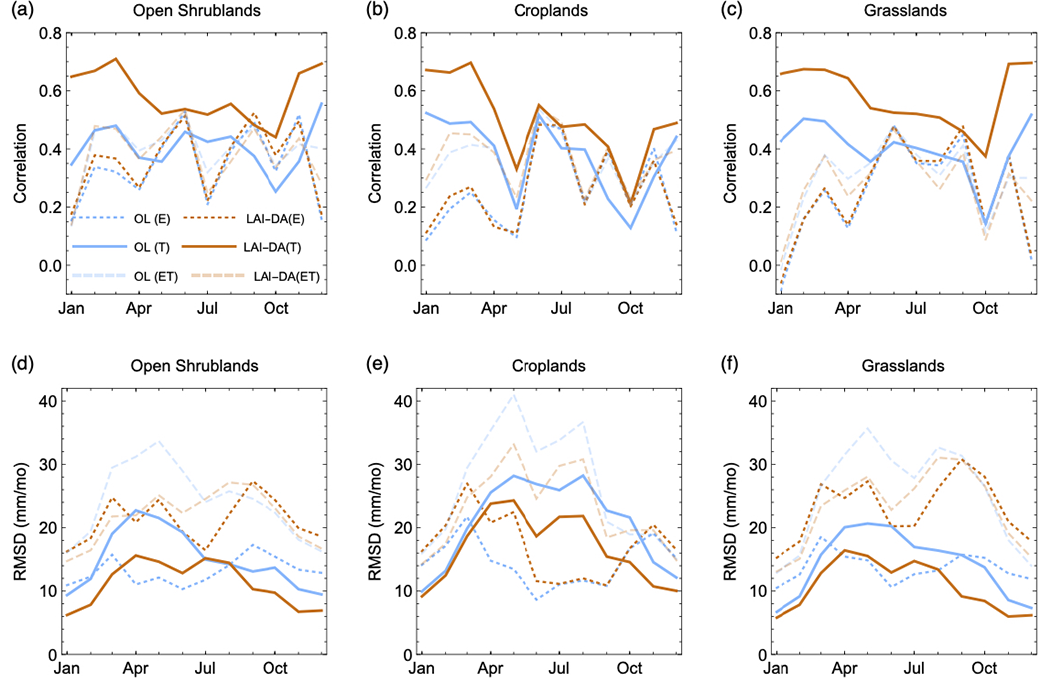
Figure 5. Median of the interannual (a–c) correlation and (d–f) RMSD of evaporation ( E ), transpiration ( T ), and evapotranspiration (ET) averaged over the major land cover classifications for the OL and LAI-DA simulations for the period of 2009–2019.